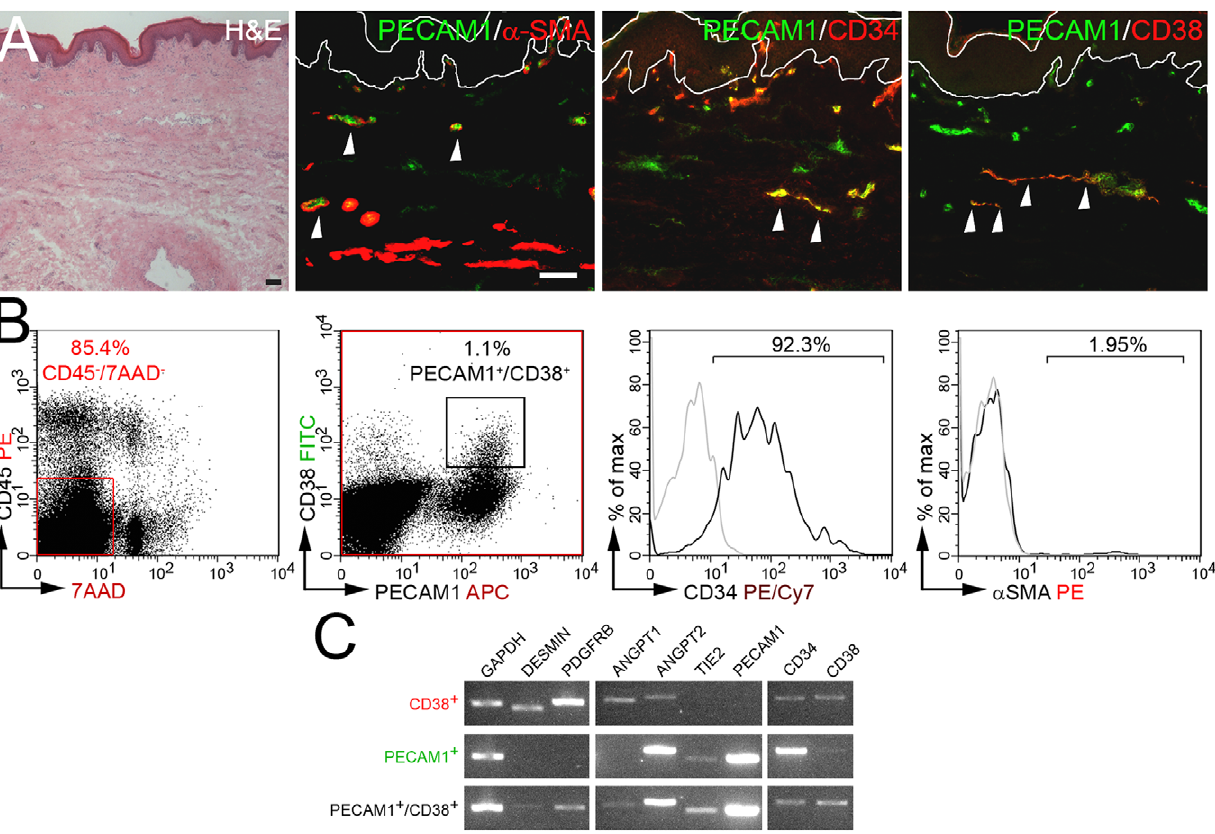
Figure 6. Identification of PECAM1 + /CD38 + cells in human foreskin. (A) Expression of PECAM1, a -SMA, CD34 and CD38 in cryosections of 12 years old foreskin is detected by immunofluorescence microscopy. (B) Flow cytometry analysis of CD38 and PECAM1 expression. The proportion of CD34 and a -SMA expressing cells within the PECAM1 + /CD38 + cell population was determined (histograms). (C) Expression profile of sorted non- hematopoietic CD38 + , PECAM1 + and PECAM1 + /CD38 + cell populations. Bars 100 m m.